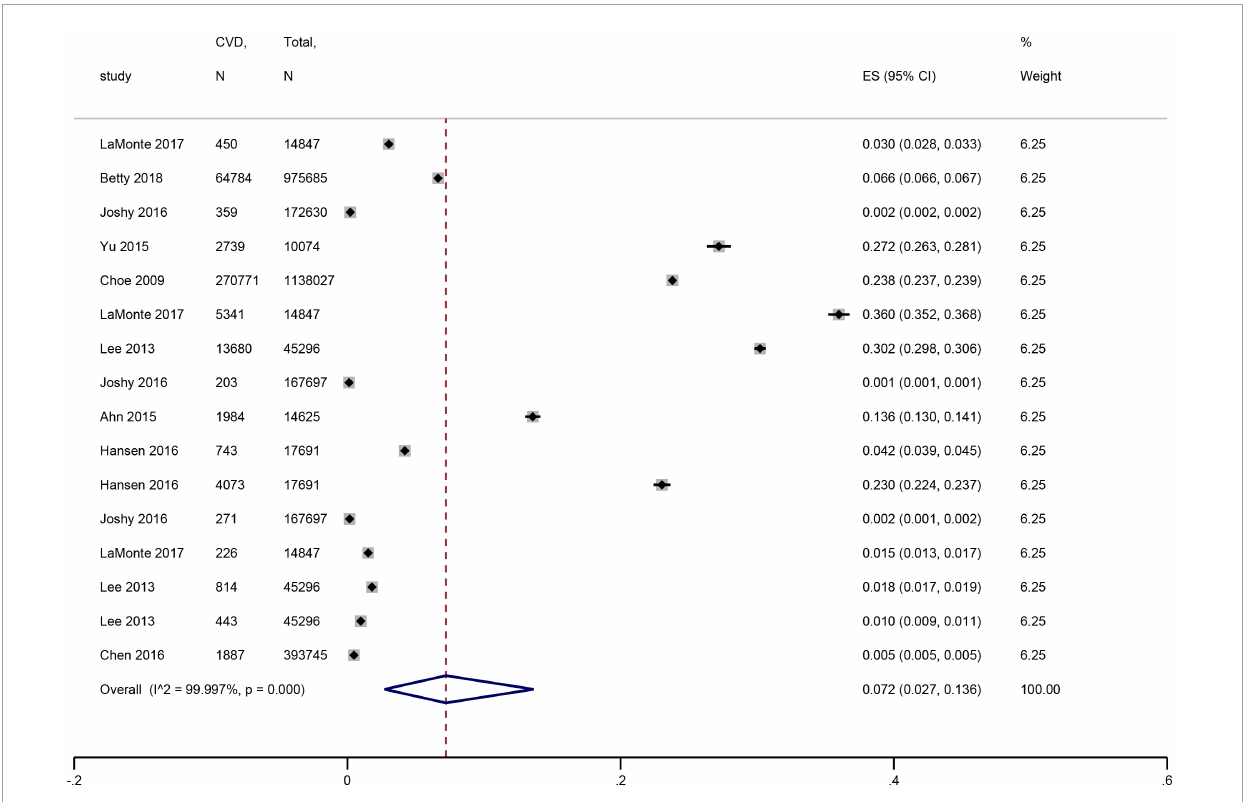
FIGURE2 Forest plot of the prevalence of cardiovascular disease in patients with periodontal disease. In the forest plot, the diamond indicates the pooled estimate. Red boxes are relative to study size and the black vertical lines indicate 95% CIs around the effect size estimate.